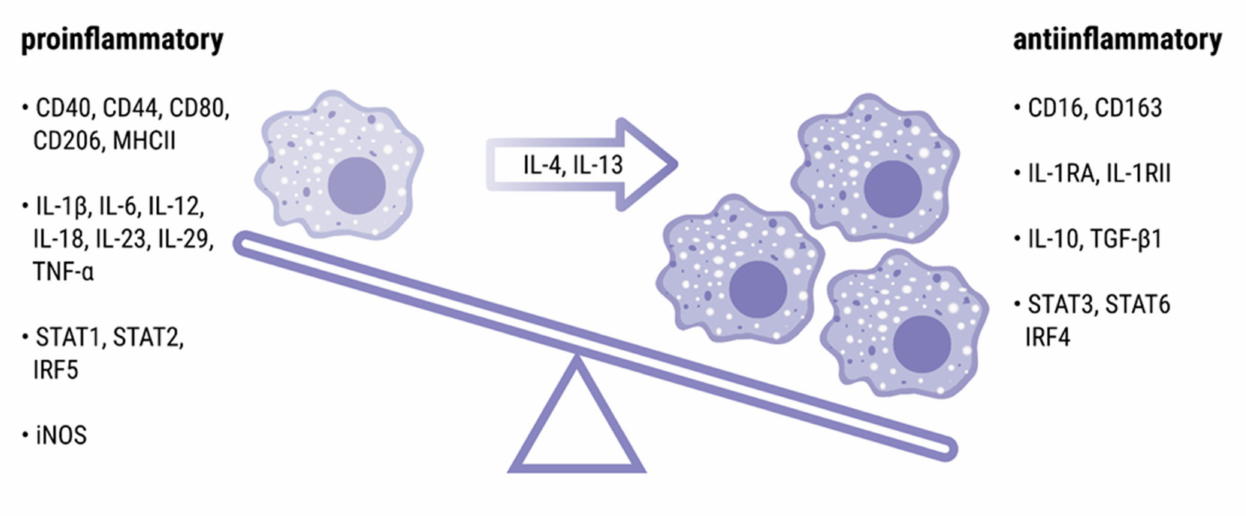
Figure 2. Macrophages’ polarization upon the action of IL-4 and IL-13 from classically activated/inflammatory (M1) phenotype to alternatively activated (M2)